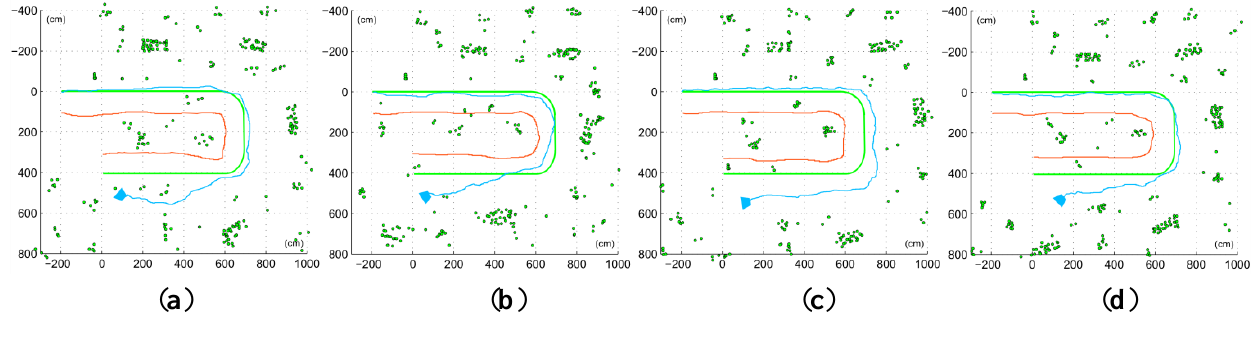
Figure 12. Estimations obtained for the rest of captured sequences, performing the trajectory several times and processed with the proposed